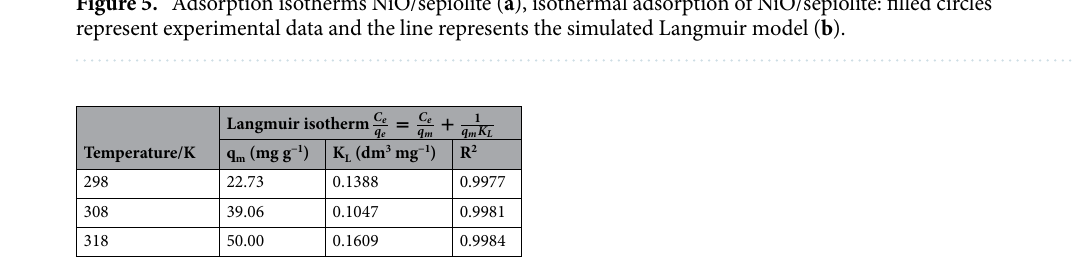
Table 2. Langmuir parameters and correlation coefficients for methylene blue adsorption onto NiO/sepiolite.